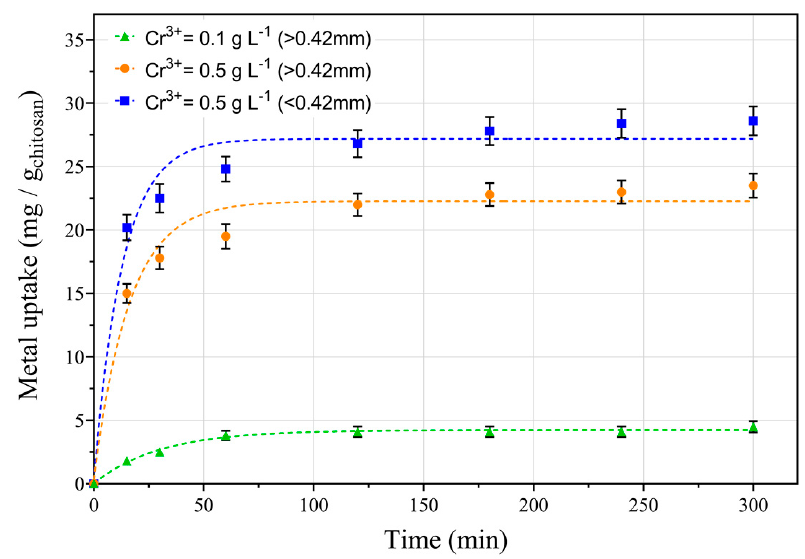
Figure 2. Effect of the grain size of the flakes on the adsorption of Cr(III) on chitosan (100 mg), at pH = 3.8, T = 20 °C, and C 0 = 100 and 500 mg L − 1 of Cr(III).